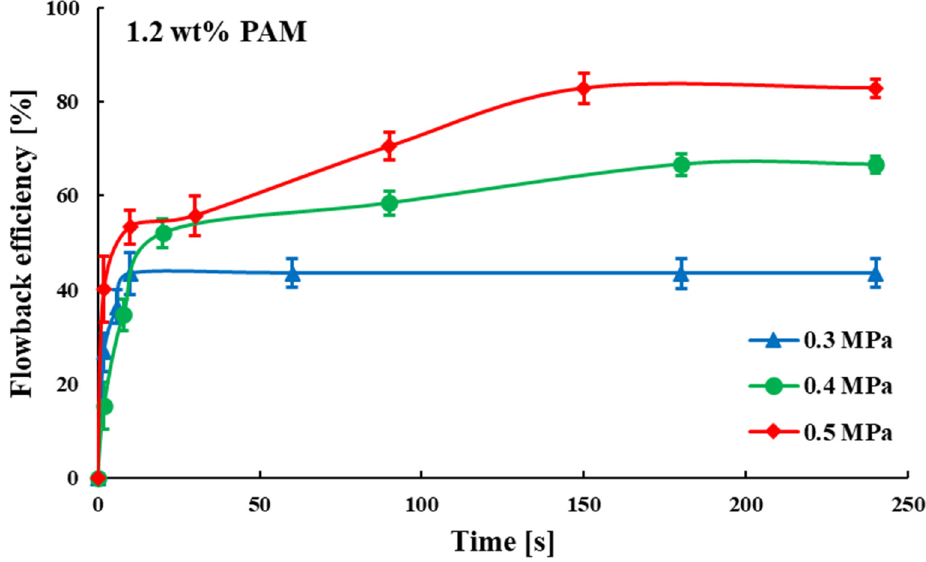
Figure 11. Relationship between time and fl owback e ffi ciency of fracturing fl uid (1.2 wt%).